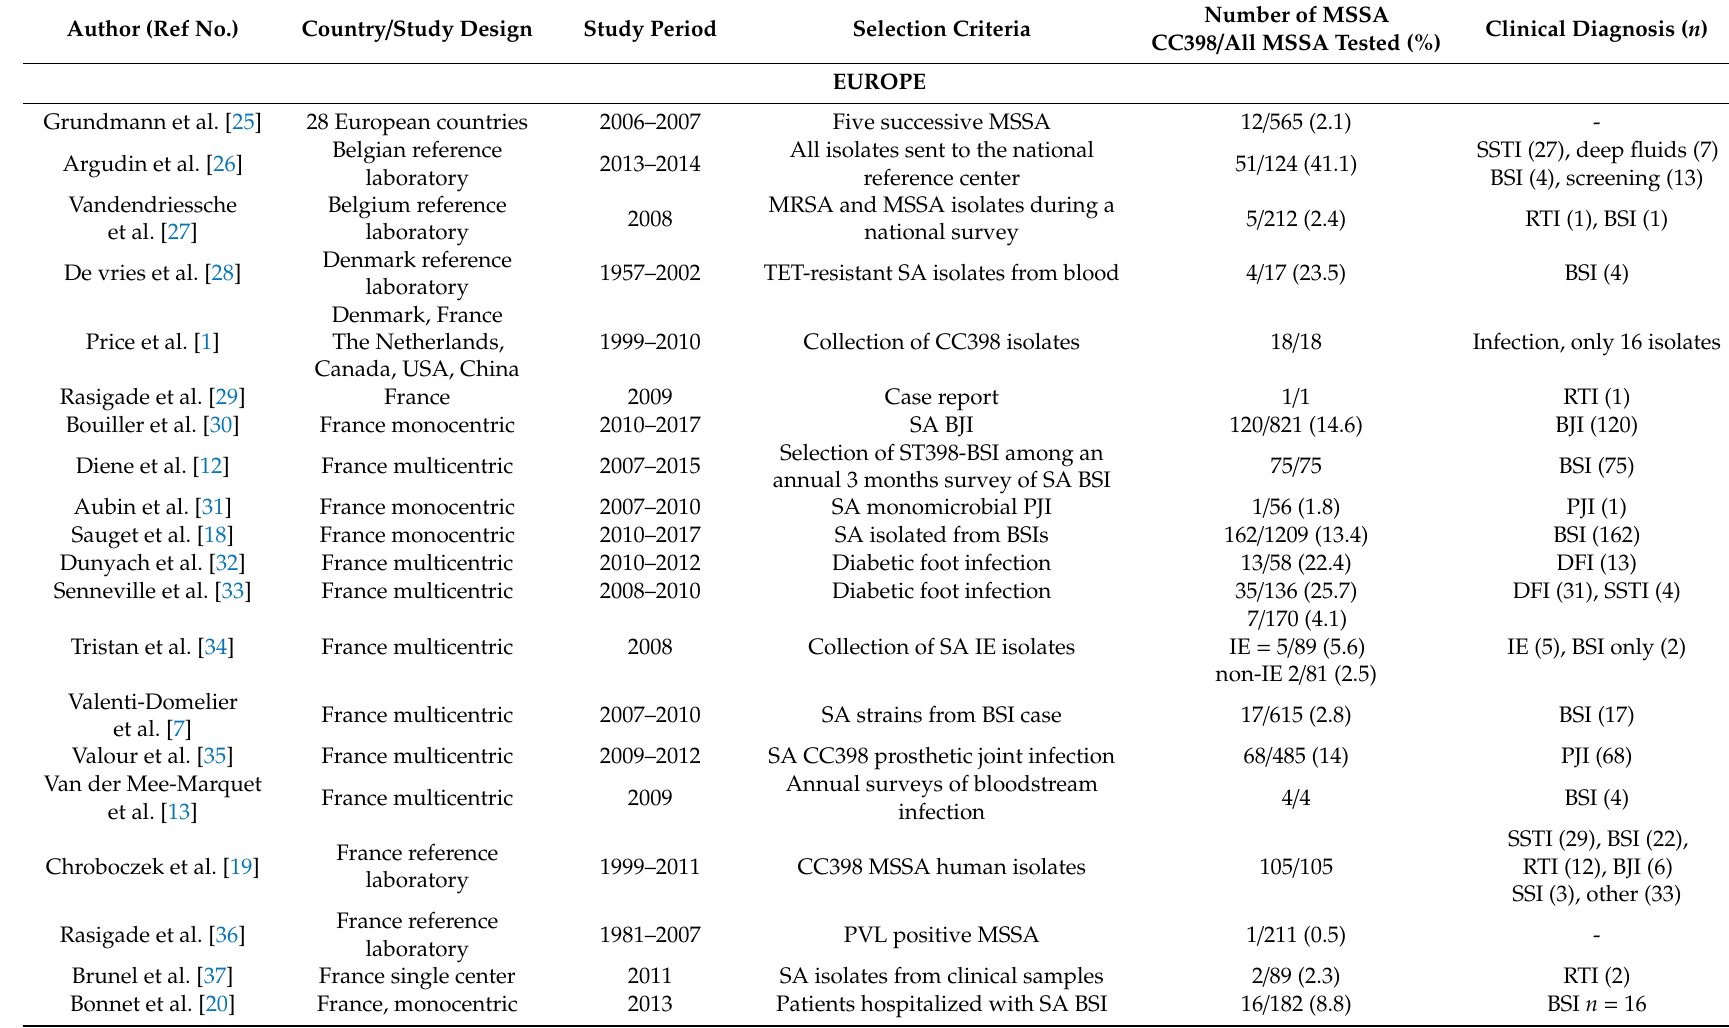
Table 1. Frequency and clinical diagnosis of MSSA CC398